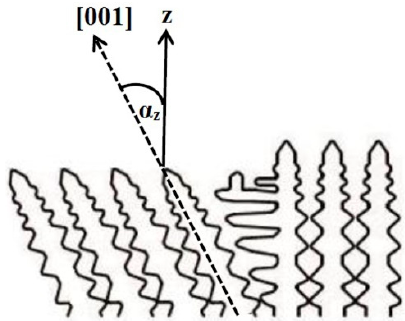
Figure 1. Angle α z between crystallization and crystal [001] directions in a scheme of the dendritic structure.